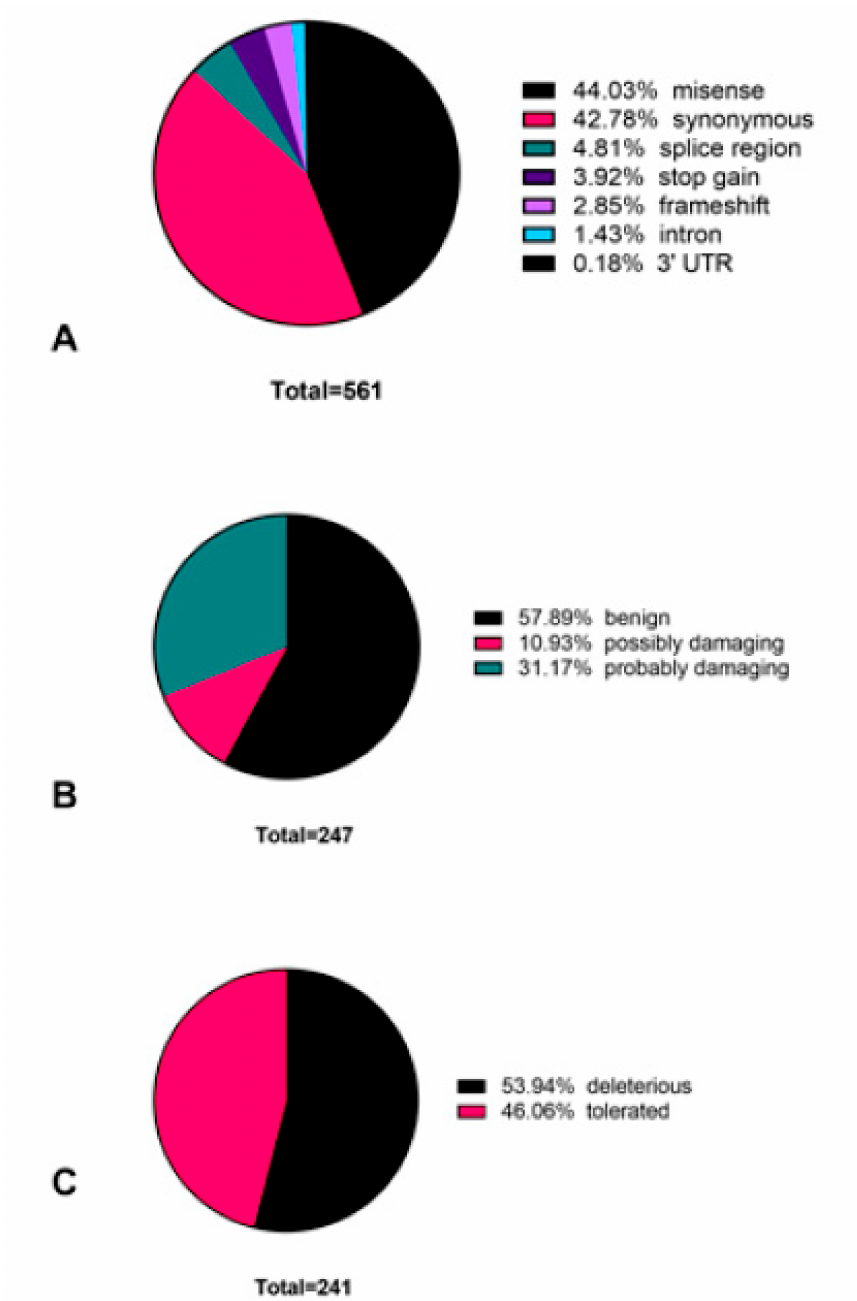
Figure 2. Classification of somatic variants. A total of 561 variants were classified by consequence ( A ), PolyPhen score ( B ), and SIFT score ( C ).